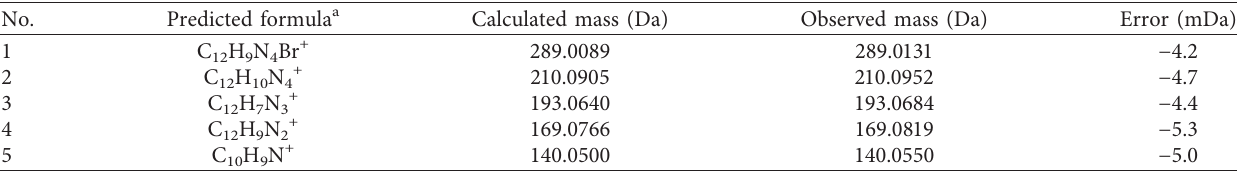
Figure 2: The product ion spectra and proposed fragmentation pathways of meridianin Table 1: Empirical formula, observed and calculated mass, and mass errors of the principal fragment ions observed in the product ion mass spectrum of [MC+H] + .